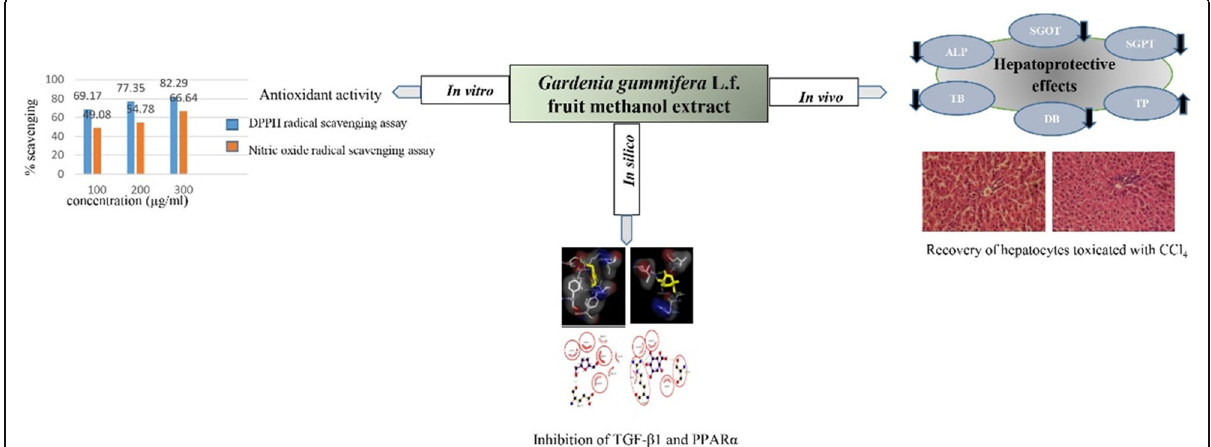
Fig. 7 Schematic model showing the effects of the active compounds in extracts on hepatoprotective mechanism. ↑ - Increase of biochemical marker, ↓ -Decrease of biochemical marker, SGOT- Serum glutamyl oxaloacetate transaminase, SGPT- Serum glutamyl pyruvate transaminase, ALP- Alkaline phosphatase, TP- Total protein, TB- Total bilirubin, DB- Direct bilirubin. CCl 4 - Carbon tetrachloride, TGF β 1- Transforming growth factor- beta 1, PPAR α - Peroxisome proliferator-activated receptor